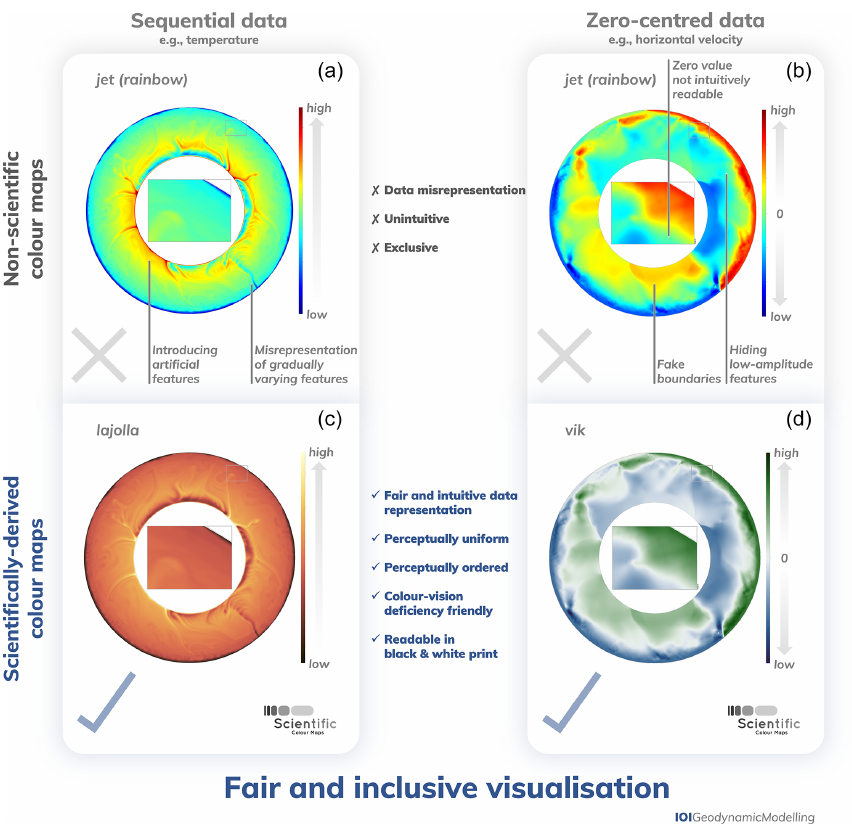
Figure 12. Effective visualisation through a scientific use of colours. Non-scientific colour maps (a, b) like rainbow always misrepresent data, are often not intuitive, and are inaccessible to a large portion of the readers, while scientific colour maps (c, d) like lajolla or vik (Crameri et al., 2020) ensure unbiased and intuitive data representation and are inclusive to readers with colour-vision deficiencies and even colour